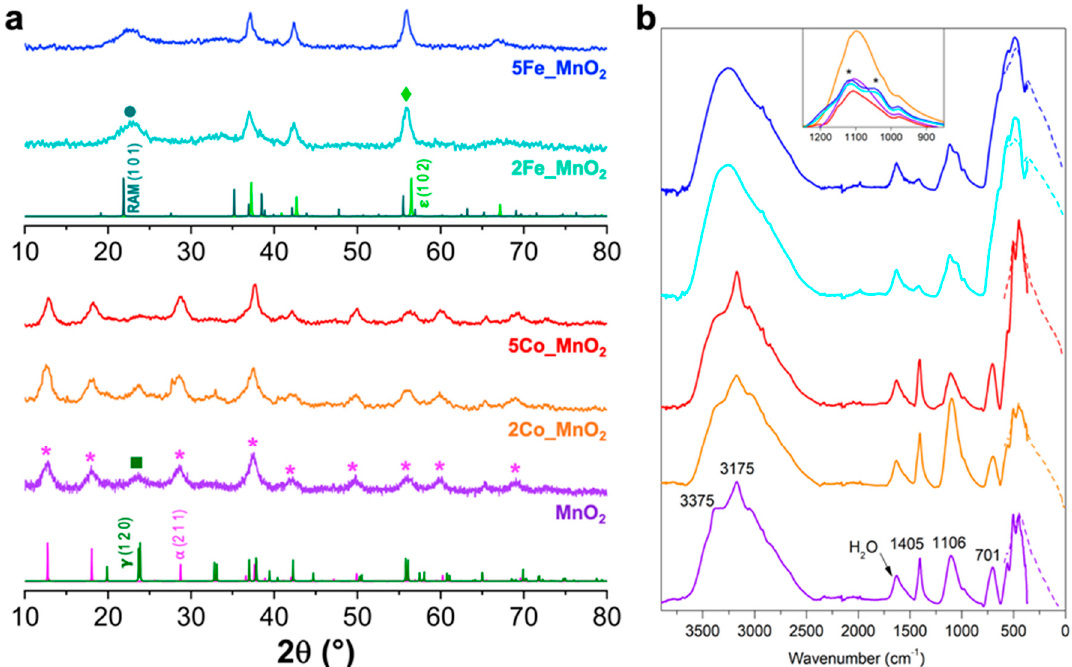
Figure 2. ( a ) Comparison of XRPD patterns relative to bare MnO 2 , Co- and Fe-doped powders. X-ray lines of α -, γ -, ramsdellite and ε -polymorphs are also reported together with the main diffraction peaks and the corresponding Miller’s indices; ( b ) mid- and far-infrared spectra (FIR) for MnO 2 samples.